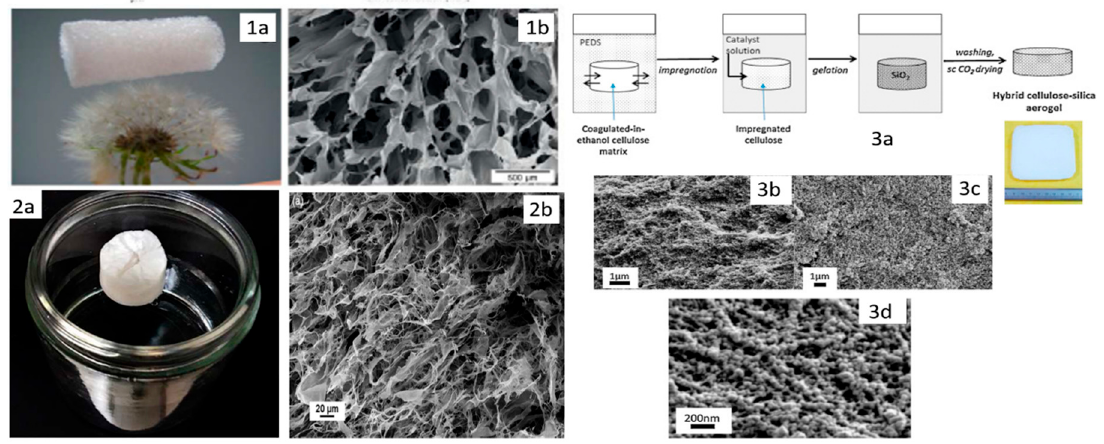
Figure 4. ( 1 ) TEMPO-oxidized and mechanically blended cellulose nanofibrils (CNFs): photograph of a 0.2 CNF aerogel on top of a dandelion ( 1a ) and SEM images of 0.2 CNF aerogel pore structures ( 1b ). Reprinted with permission from [56]. Copyright (2014) Royal Society of Chemistry. ( 2 ) Photograph of floating hydrophobic CNF aerogel on water surface ( 2a ) and Field Emission Scanning Electron Microscopy (FE-SEM) images of CNF aerogels ( 2b ). Reprinted with permission from [59]. Copyright (2016). ( 3 ) Schematic illustration of the preparation route of cellulose-silica composite aerogels, with a photograph of a composite aerogel sample ( 3a ), SEM images of composite aerogels from 3% cellulose-1-ethyl-3-methylimidzolium acetate- (EmimAc) DMSO solution, manufactured with molecular di ff usion ( 3b ) and forced flow impregnation ( 3c , d ). Reprinted with permission from [60]. Copyright (2015) Elsevier.